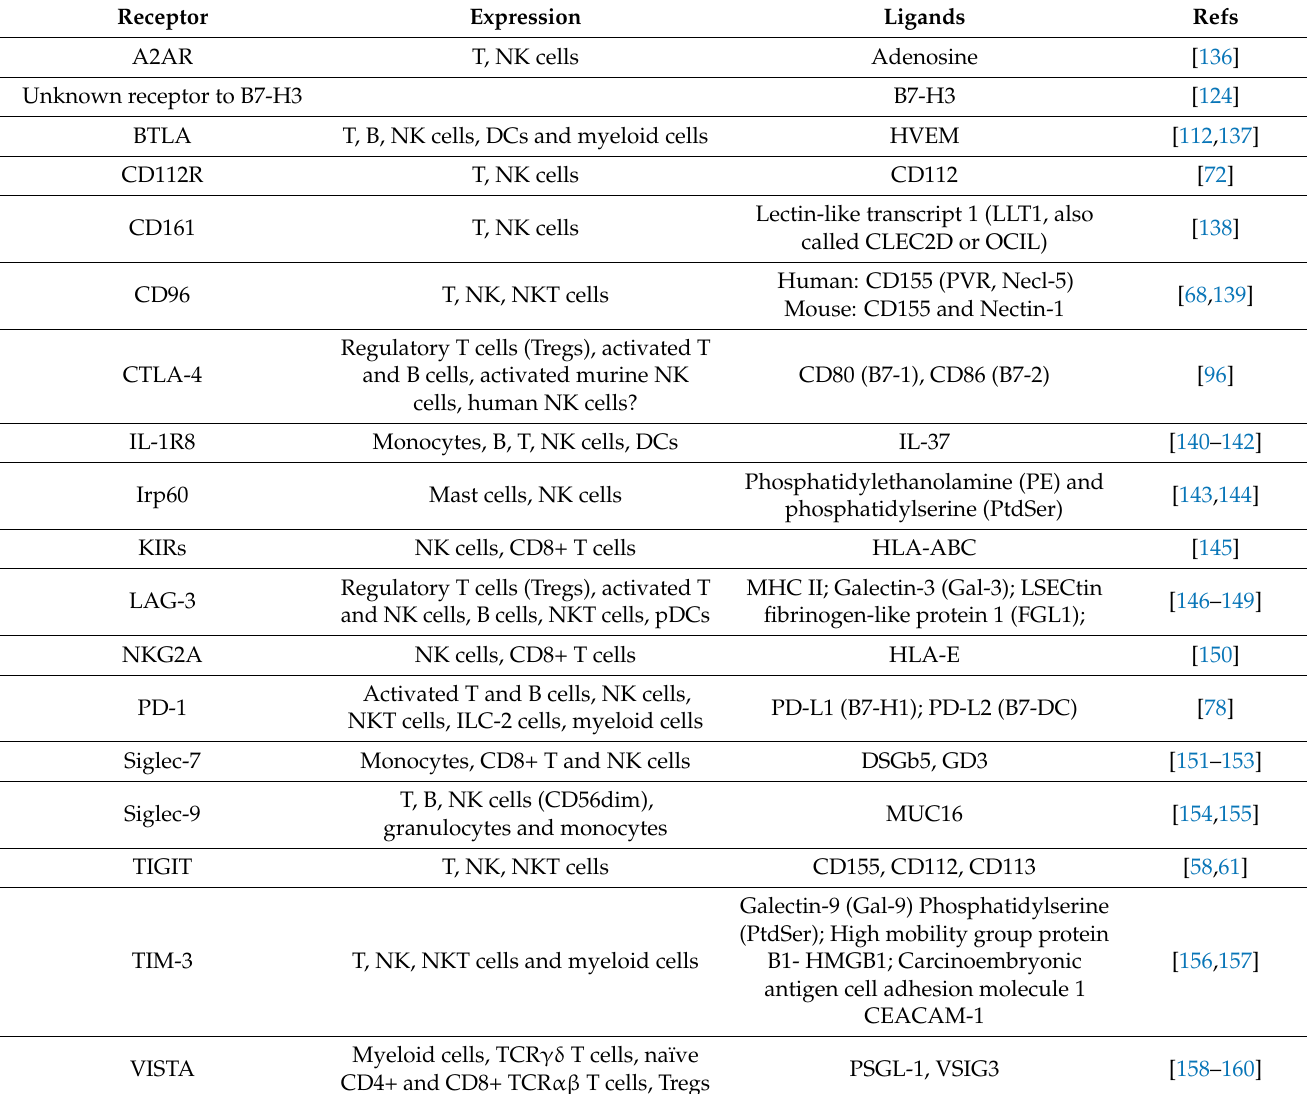
Table 1. Checkpoint receptors expressing cells and corresponding